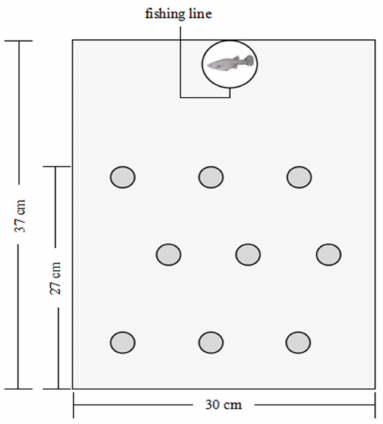
Figure 1. Schematic diagram of the experimental